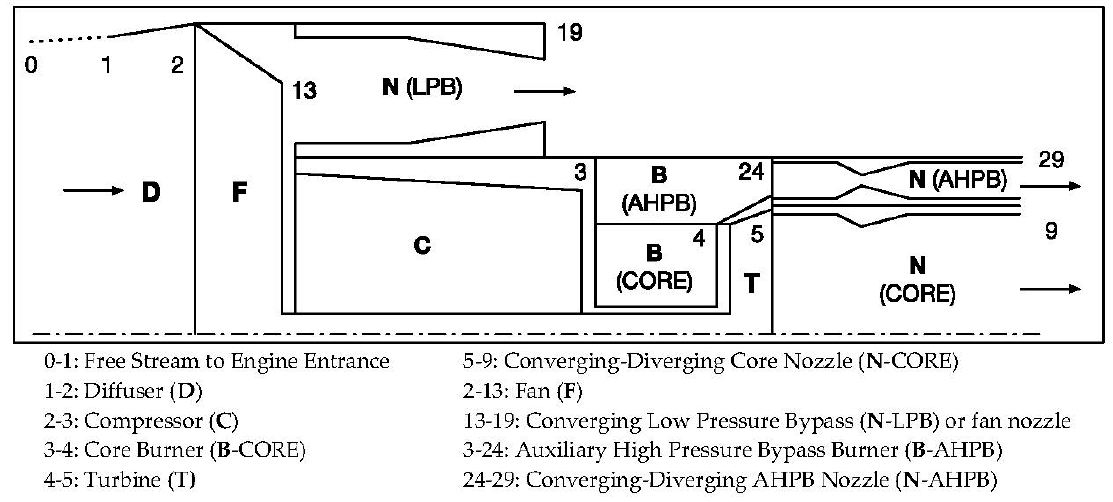
Figure 1. Schematic layout of the turbofan engine with an auxiliary high-pressure bypass (AHPB).